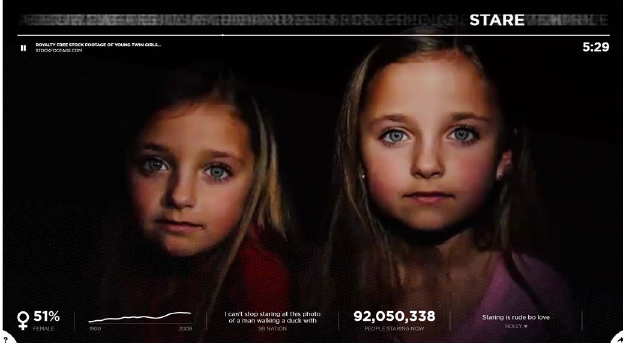
Figure 2: Jonathan Harris and Greg Hochmuth, Network Effect